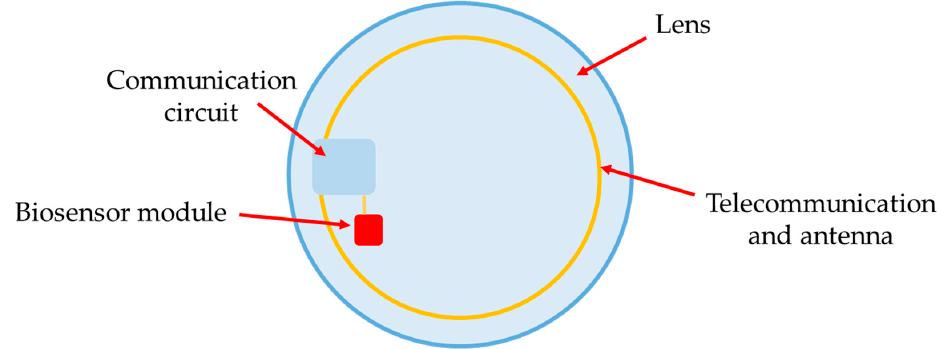
Figure 13. Smart sensor for glucose level measurement developed into a contact lens.